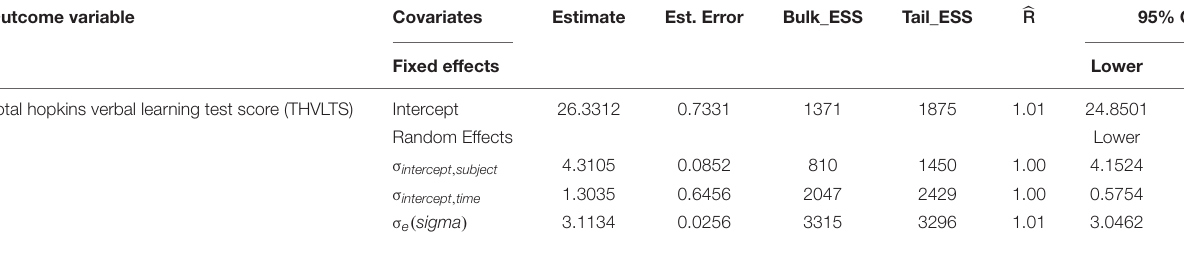
TABLE 1 | Results from the fitted null model: Model 1.